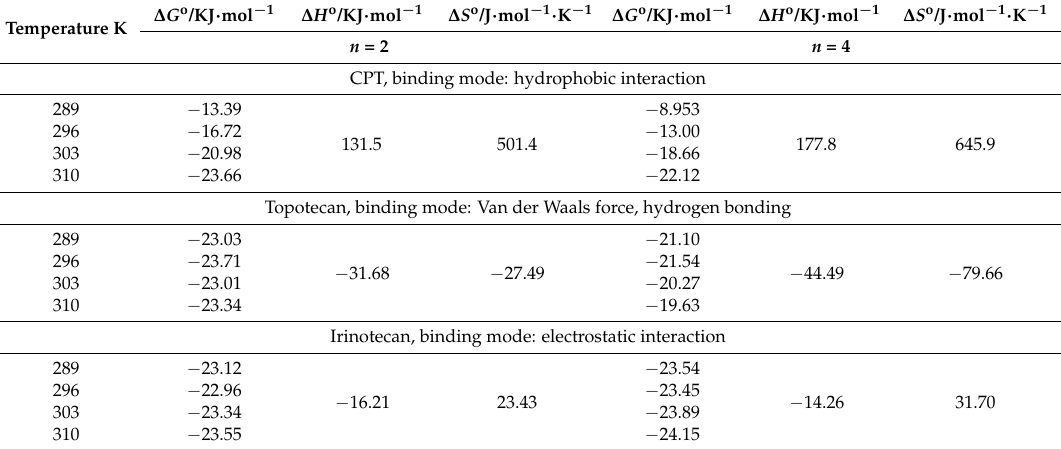
Table 2. Thermodynamic parameters of IVIG binding to six camptothecin analgues at pH 4.0 [43–45]. Temperature